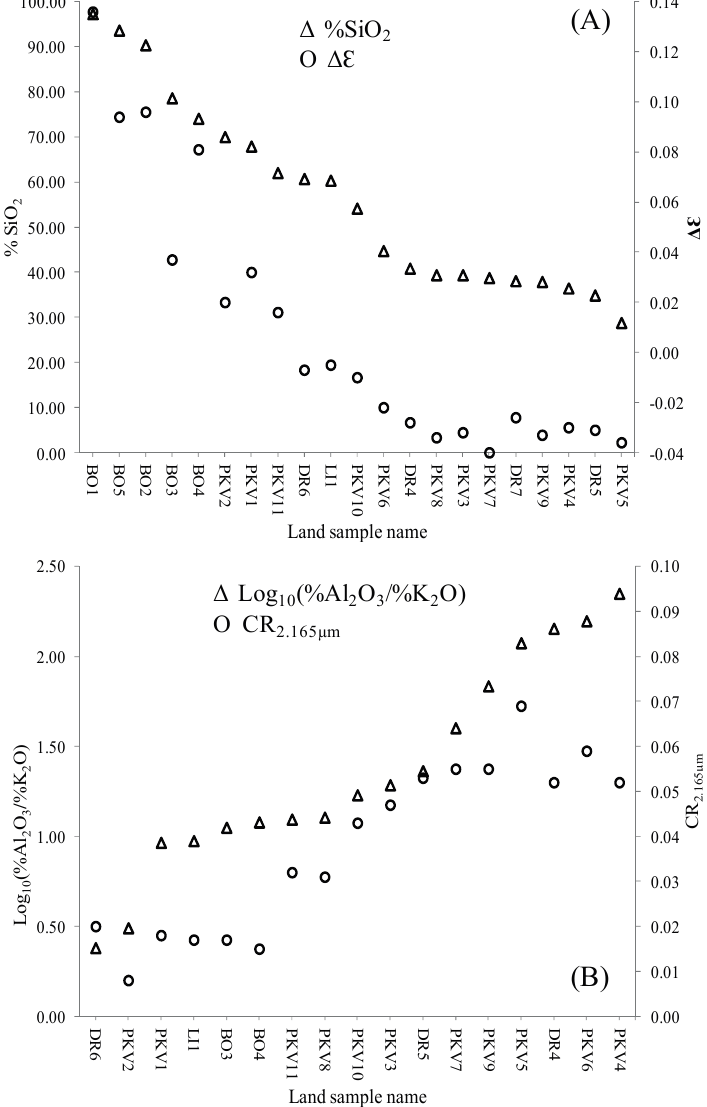
Figure 13. ( A ) Comparison of measured %SiO values (secondary y-axis) of different land samples; ( B ) Comparison of measured %Al O /%K O values (primary y-axis) and calculated CR 2 3 2 of the different land samples; logarithmic values were used for the graphic